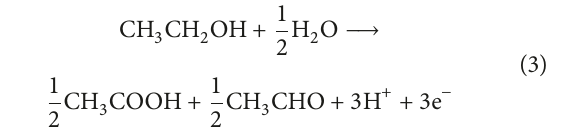
and Pt 100 /C have only one peak ( 3 ). In the negative-going scan (Figure 7(b)), all electrocatalysts exhibit two peaks (1 󸀠 and 2 󸀠